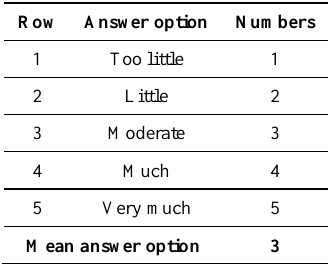
Table 2 . Response alternatives and encoding